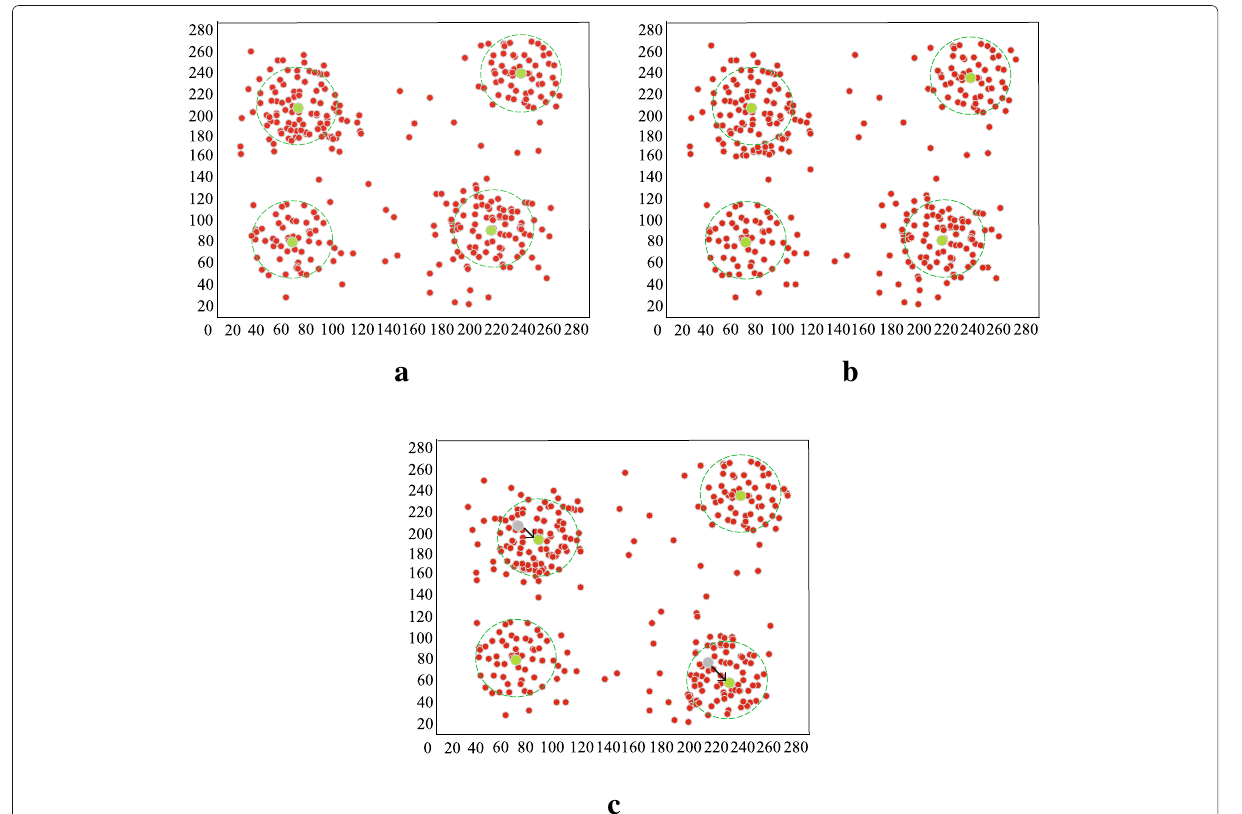
Fig. 4 Distribution of mobile devices at three different moments of the cloudlet movement. a States at time t 0 . b States at time t 1 . c States at time t 2